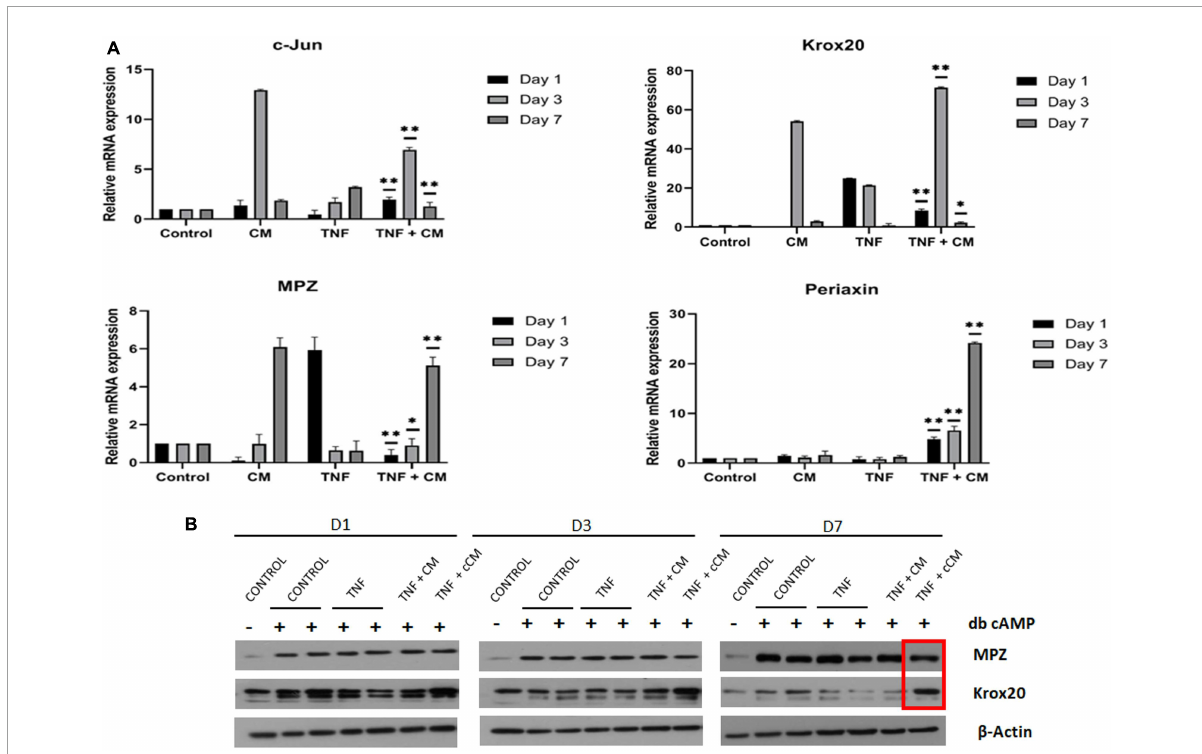
FIGURE6 (A) CM induces myelination. Expression of myelin related transcription factors (c-Jun , and Krox-20 ) and genes encoding structural proteins (MPZ and Periaxin) in sciatic nerves inflamed with TNF (25 ng/mL) and treated with CM for 1, 3 and 7 days. The results are expressed as the mean ± SD of four independent experiments. ∗ p ≤ 0.05, ∗∗ p ≤ 0.01 using ANOVA comparing TNF with TNF-CM treated samples. (B) TNF does not induce demyelination in in vitro -myelinated Schwann cells. Western blots showing levels of Krox-20 and MPZ myelin-related proteins in Schwann cells (SCs) inflamed with TNF (25 ng/mL) at 1, 3 and 7 days of culture. Technical duplicates are shown in the western